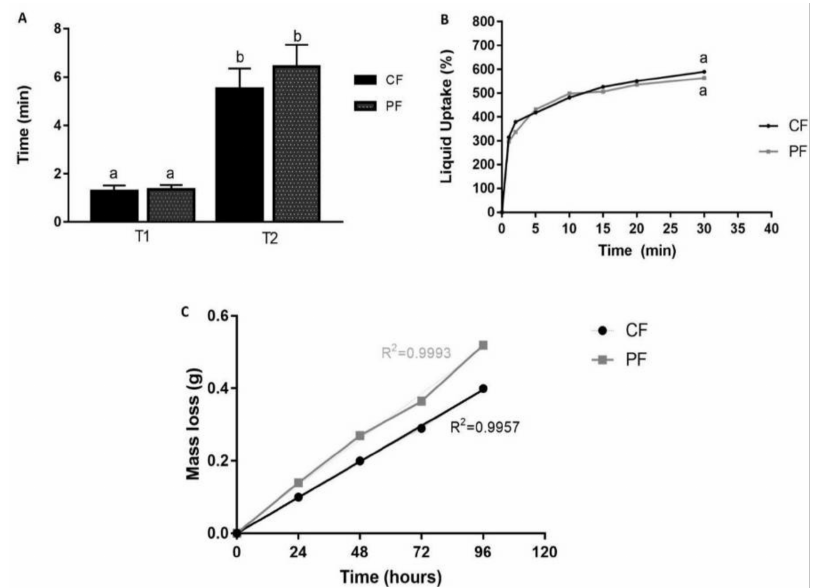
Figure 3. Disintegration time of ODFs; ( A ) T1: time in which artificial saliva cross the films; T2: time to complete disintegration (appearance of a hole). ( B ) CF and PF uptake of artificial saliva over time. ( C ) Mass loss in water vapor permeability test over time. Same lowercase letters show statistical equality according to t